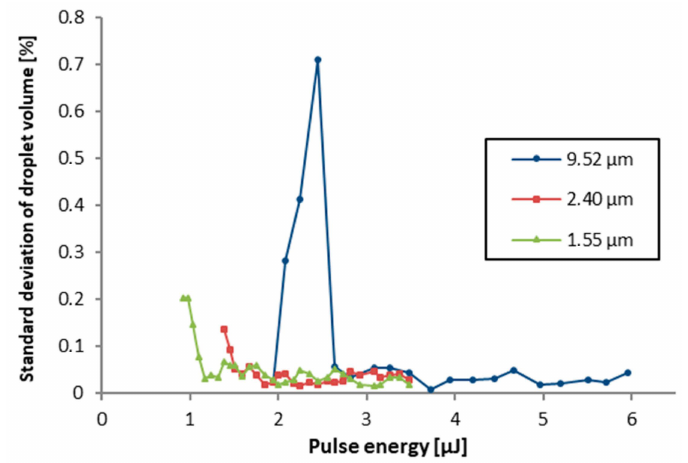
Figure 8. Standard deviation obtained from measured droplet volumes of 5 × 5 arrays at three different fluid film thicknesses as a function of the pulse energy. Process parameters: λ = 515 nm, gap between donor and receiver d G = 200 µ m and polyimide film thickness d PI = 3.5 µ m. Data points were connected by lines to guide the